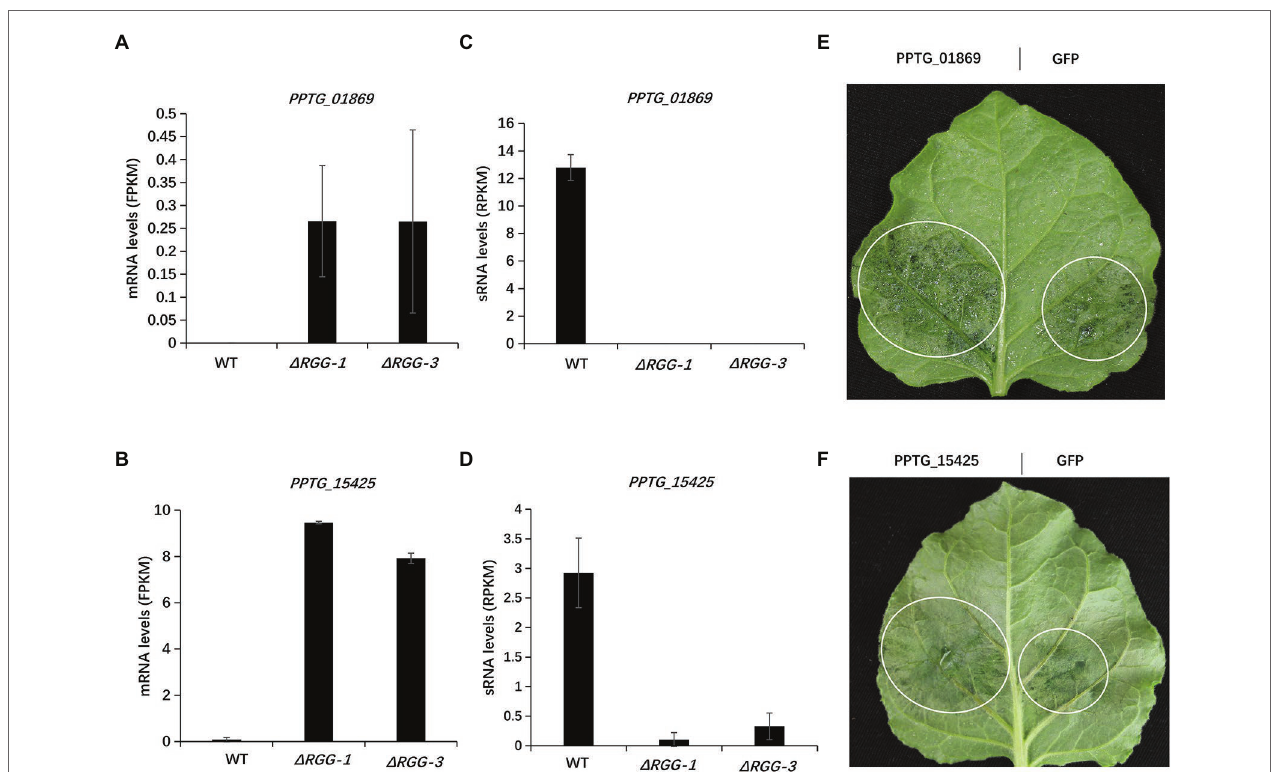
FIGURE 5 | The enhanced pathogenicity of mutants PpAGO3 Δ RGG1 and PpAGO3 Δ RGG3 was likely resulted from activation of effector genes. (A,B) The mRNA levels of two upregulated RXLR effector genes, PPTG_01869 and PPTG_15425 , in PpAGO3 Δ RGG1 and PpAGO3 Δ RGG3 mutants. (C,D) The changes of PPTG_01869 and PPTG_15425 mRNA levels were negatively with the corresponding 25–26 nt sRNA levels variation in PpAGO3 Δ RGG1 and PpAGO3 Δ RGG3 mutants. (E,F) Phytophthora parasitica caused much larger lesion on PPTG_01869 and PPTG_15425 transient expressed N. benthamiana leaves than control GFP , respectively. The white circle marked the water-soaked lesion region. Similar results were obtained from three independent